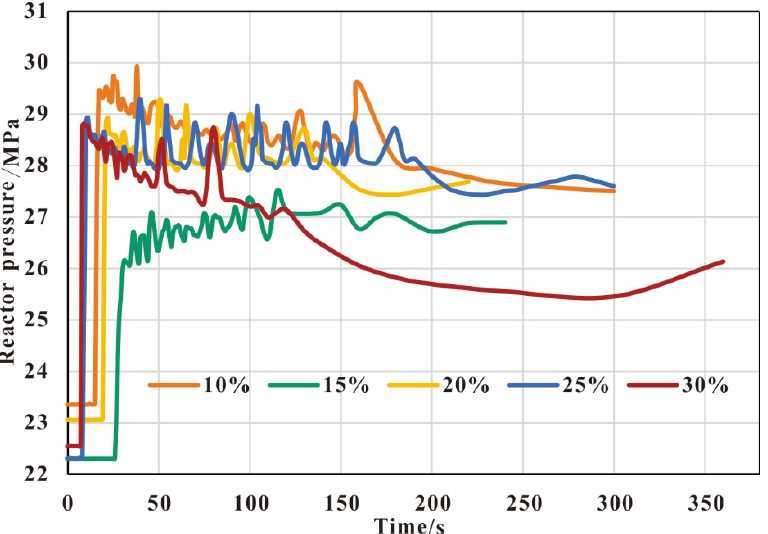
Figure 8. Pressure changes in the reactor during the supercritical water–diesel reaction experiment under different oil–water ratios.